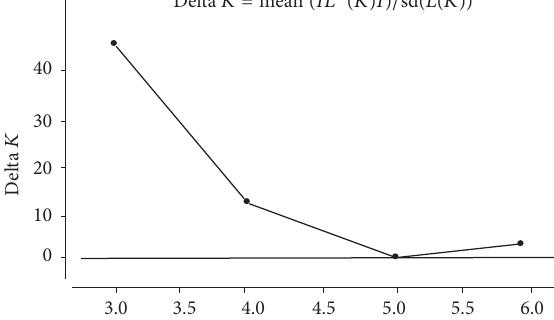
Figure 7: Result of Bayesian assignment analysis suggesting 𝐾 = 3 as most likely number of clusters as delta 𝐾 value maximum at 𝐾 = 3 . population size in short span of time. This presumption might hold true as more accessible individuals growing in the region have been exploited by locals for construction of houses and other household products along with the utilization of their tender shoots as popular vegetable